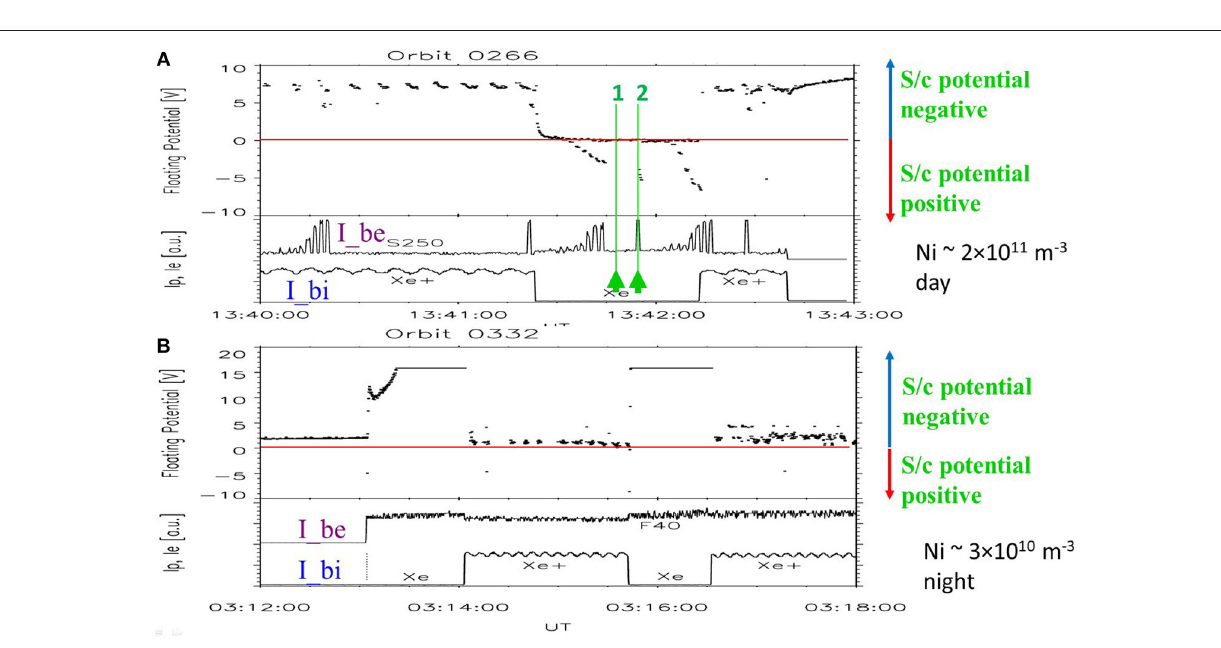
FIGURE 6 | Examples of the IK–25 spacecraft potential behavior during electron beam injections. The plots show the KM–10 floating probe potential, mean UEM electron beam and UPM plasma injector currents: (A) Orbit 0266—dayside modulated electron beam (S250 mode, G1 injector) with xenon gas/plasma neutralization (F0 mode), green vertical lines assigned 1 and 2 mark instants with the UEM beam base current and UEM beam maximum current (DC pulse); (B) Orbit 0332—nightside electron beam injection (F40K mode, G2 injector with magnetic deflector) with xenon gas/plasma neutralization (F0 mode). (Reprinted from Prech et al., 1995, with permission from